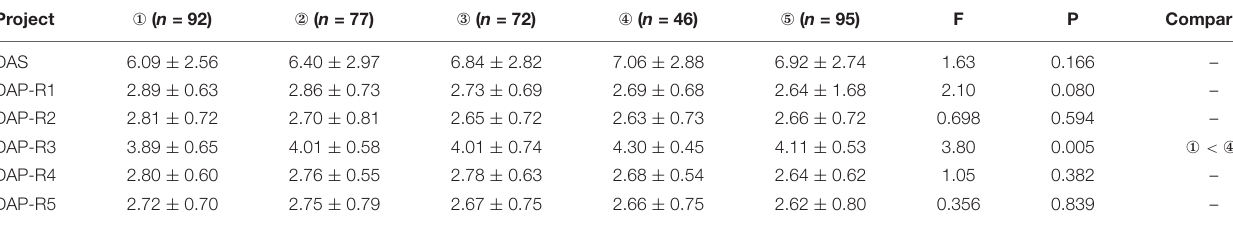
TABLE 4 | Results of a comparison of death attitude and anxiety of different funeral experiences. Project